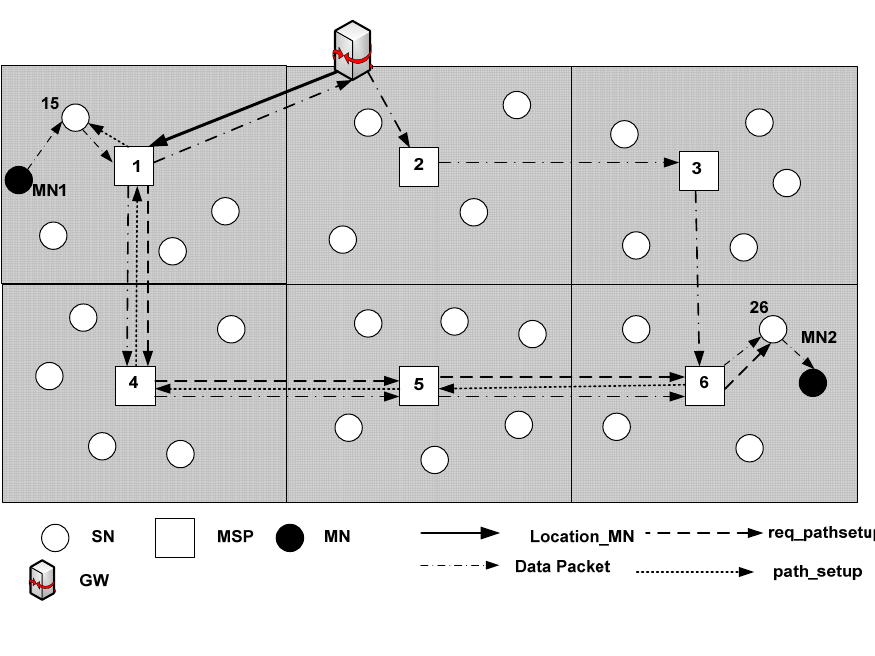
Figure 11. DLoWMob mobility scheme with Route